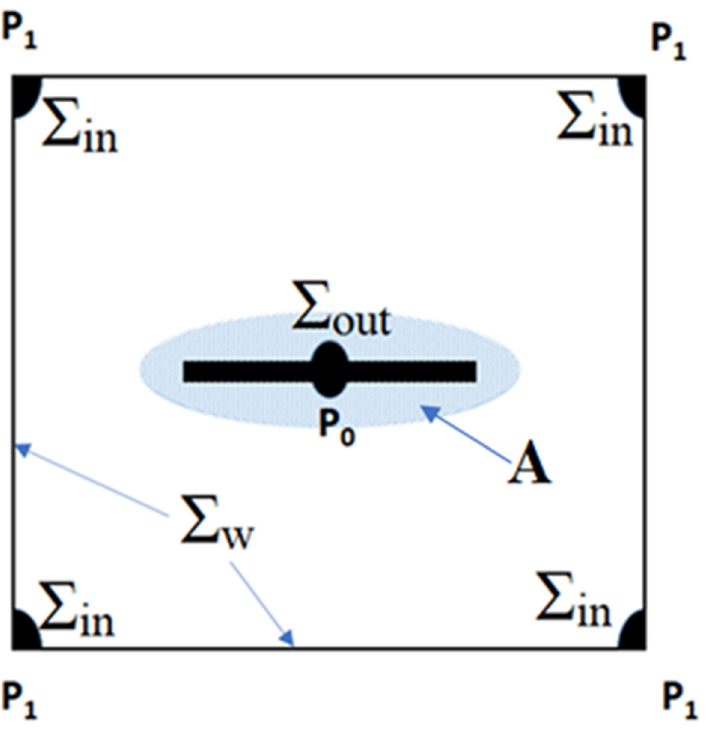
Figure 25. Calculation area for modeling the fracture cleaning process.